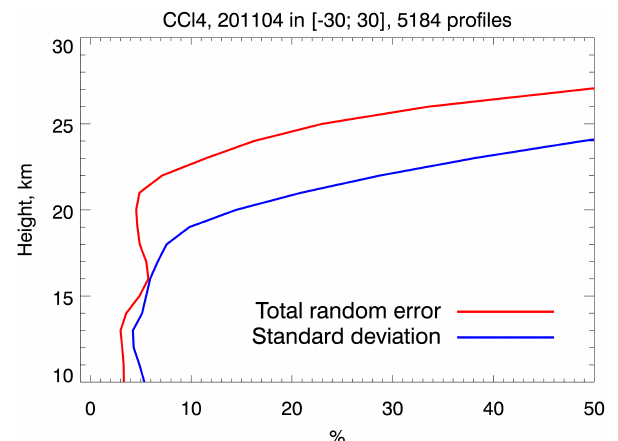
Figure 11. Altitude–latitude cross sections of MIPAS CCl 4 trends covering the entire measurement period from July 2002 to April 2012. Red colours indicate increasing CCl 4 volume mixing ratios. Blue colours indicate declining CCl 4 concentrations. Hatch- ing shows where no statistically significant trends could be calcu- lated at 2 σ confidence